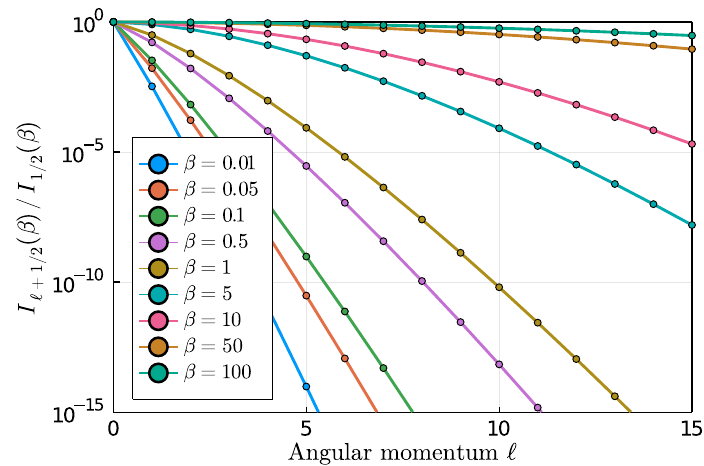
( β ) normalized to I ( β ) as a function 1 / 2 1 / 2